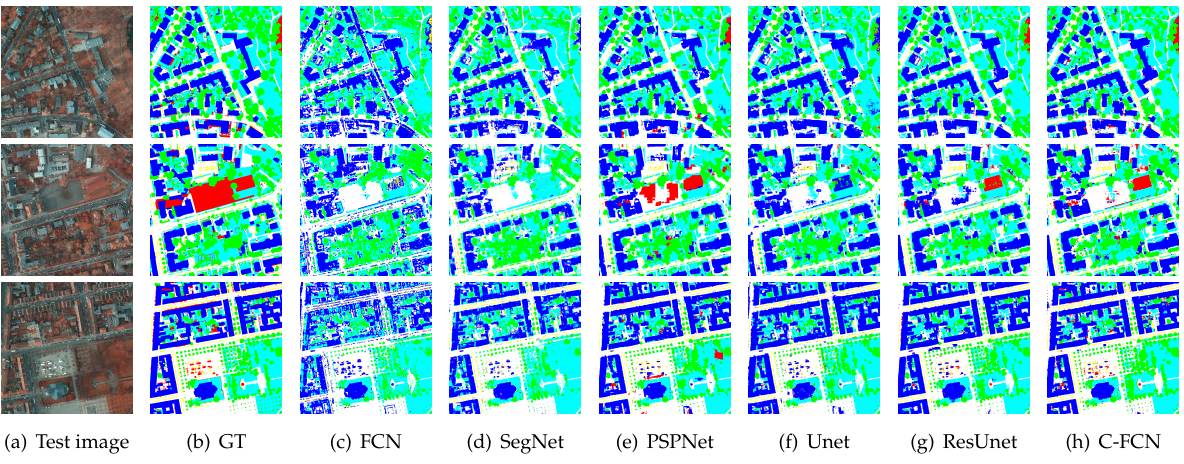
Figure 14. Visualization of some segmentation results on ISPRS Potsdam test